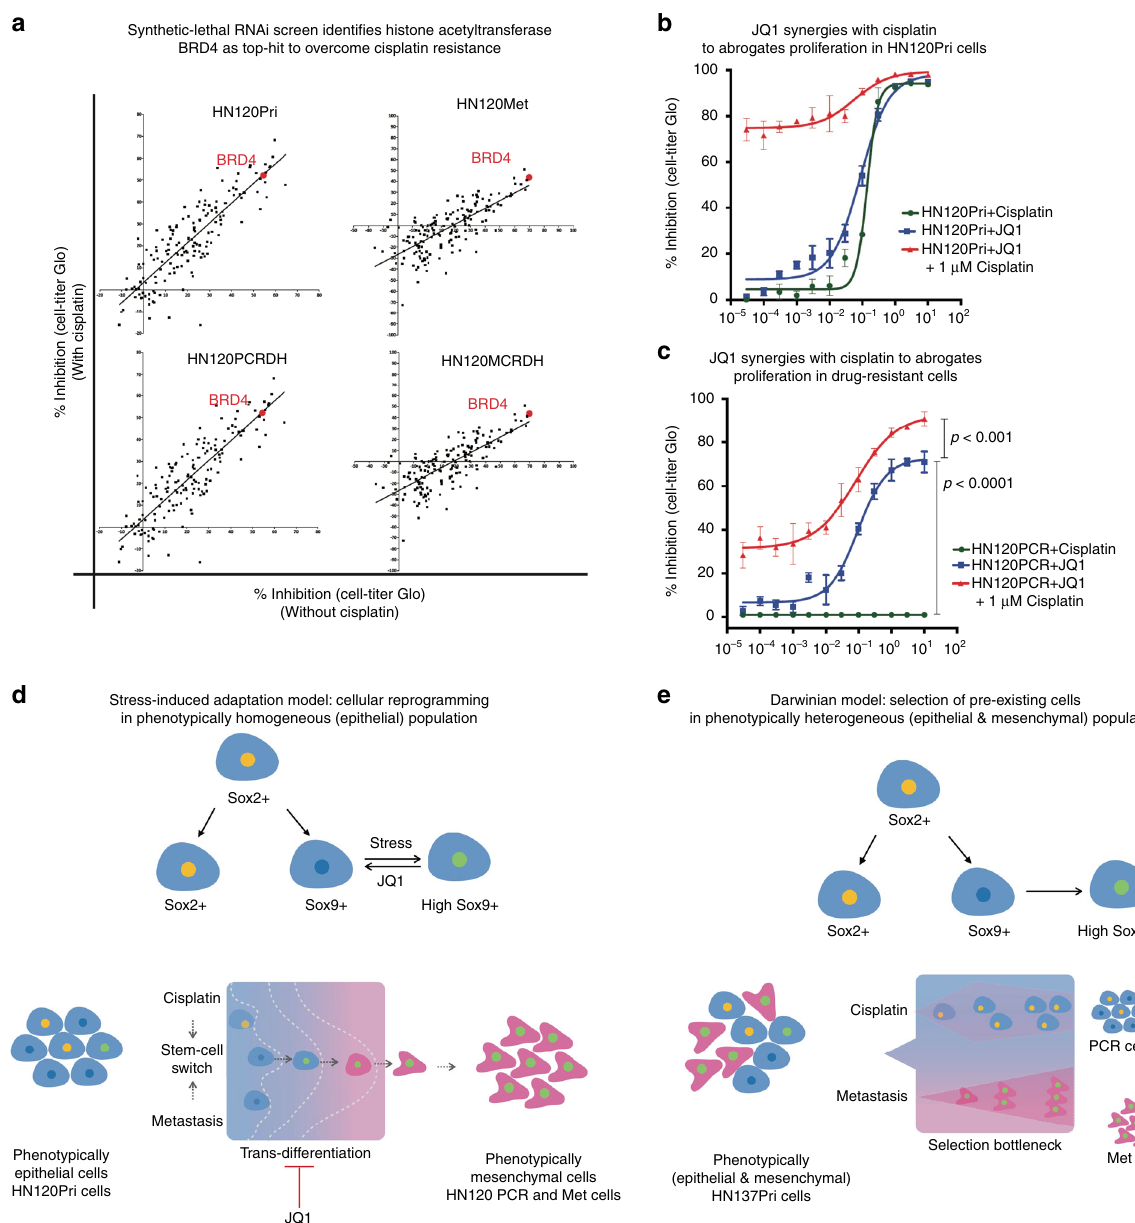
Fig. 7 Different modes of drug-resistance uncover potential for combinatorial targeting strategies using epigenetic inhibitors. a Synthetic-lethal screens with cisplatin using siRNAs against chromatin remodelers (see Fig. S6 for complementary screen using small molecule inhibitors). IC50 curves for cell viability screens in naive ( b ) and drug-resistant ( c ) HN120 cells with increasing concentration of either cisplatin or JQ1 alone, or a combination of JQ1 with 1 µ M cisplatin (mean + s.e.m. n = 3, Two-tail Student ’ s t test, *** P < 0.0001, * P < 0.001). d , e Proposed model for cellular-reprogramming (adaptive) and ‘ clonal selection ’ modes of drug-resistance and metastasis. d The phenotypic homogeneous (HN120) model depicts the adaptive mode of evolution where epigenetically poised epithelial cell populations undergo mesenchymal cell-state transition. Different stress (cisplatin or metastasis) conditions leads to similar phenotypic outcome as a result of a SOX9-mediated coordinated activation of H3K4me3- poised promoters, which can be reversed by JQ1 mediated BRD4 inhibition. e Tumor cells exhibiting pre-existing phenotypic heterogeneity (HN137) allows “ division-of-labor ” where distinct clonal populations of pre-existing ‘ designated survivors ’ can get selected depending on the context speci fi c nature of different selection